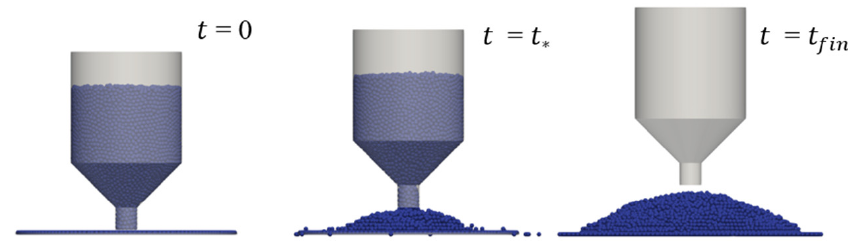
Figure 4. Simulation of angle of repose for glass beads.